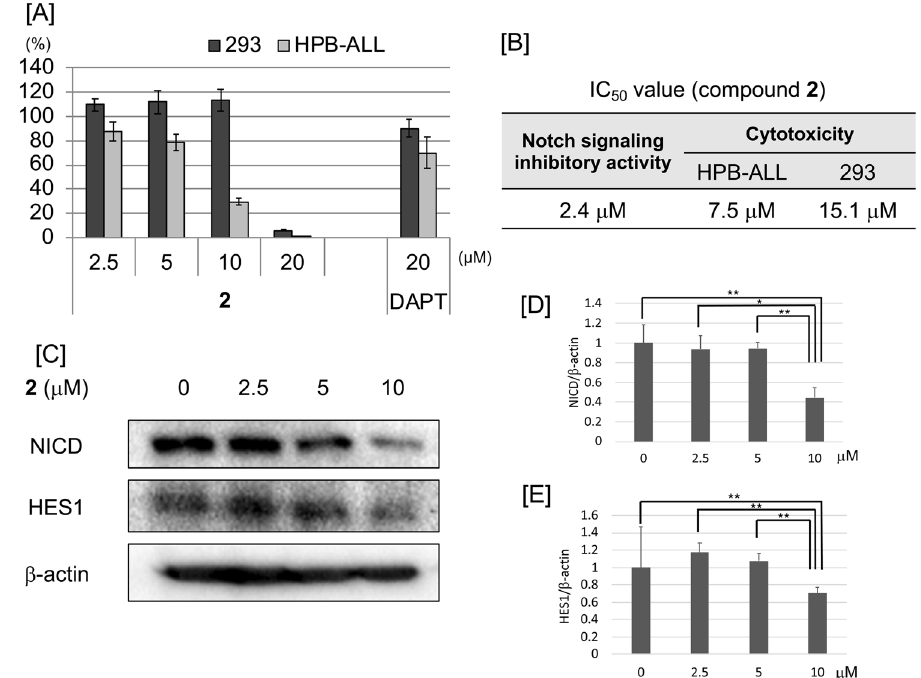
Figure 7. Effect of cowanin ( 2 ) on HPB-ALL cells. ( A ) Cytotoxicity of 2 and DAPT against 293 and HPB-ALL cells. HPB-ALL cells (1 × 10 4 cells per well) were incubated in 96-well black plates at 37 °C for 72 h. Media also contained different concentrations of compound. After incubation, AlamarBlue was added 10 μ L per well. After incubation for 4 h, using a fluorescence plate reader, fluorescence was measured and cell viability was determined. Data are presented as the mean with SD from three independent experiments. ( B ) IC 50 values of cowanin ( 2 ) in Notch signaling inhibitory activity and cytotoxicity. ( C ) Western blot analysis of NICD and HES1 expression in HPB-ALL cells after treatment with 2 . HPB-ALL cells (1 × 10 6 cells/dish) were incubated in a 6-cm dish for 72 h at 37 °C with 2 . The effect on protein expression was analyzed by Western blotting. β -Actin was used as internal control. ( D , E ) Relative protein levels of NICD and HES1 analyzed by densitometry. Data are presented as the mean with SD from three independent experiments. * P < 0.05 is considered statistically significant. P values were analyzed by Student’s t